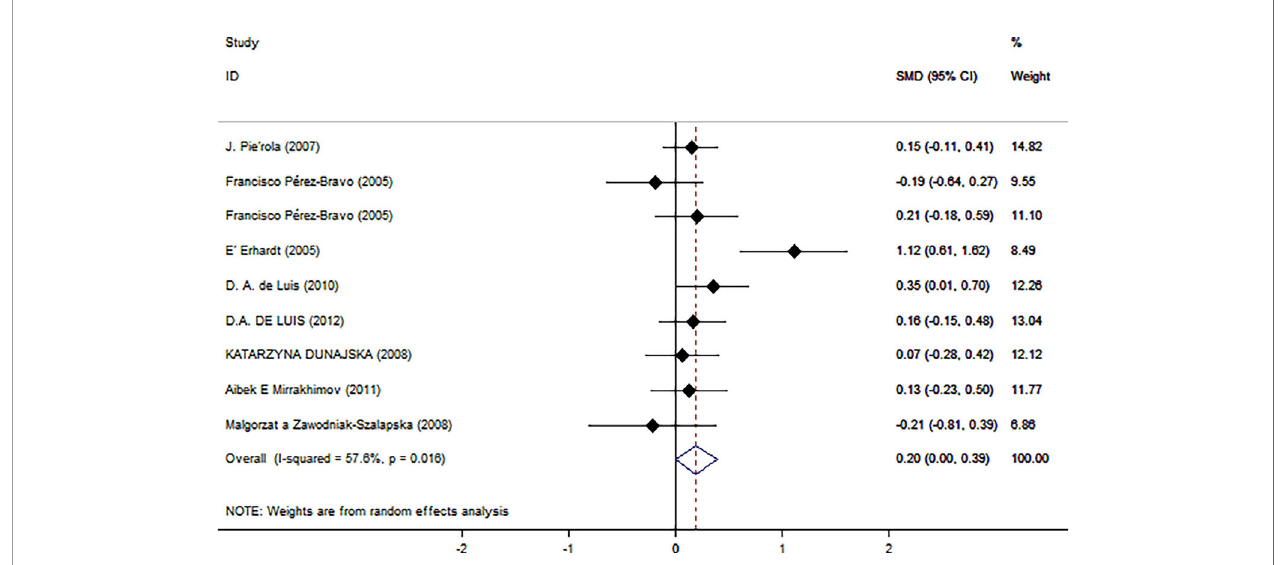
FIGURE 2 | Insulin level as an index of insulin resistance. Forest plot showing the effect size of the correlation between Trp64Arg mutation and insulin resistance. 95% con fi dence intervals (CIs) are expressed in bars (each group) and diamond (all studies). Summary estimates are analyzed using a random-effects model. SMD, standardized mean